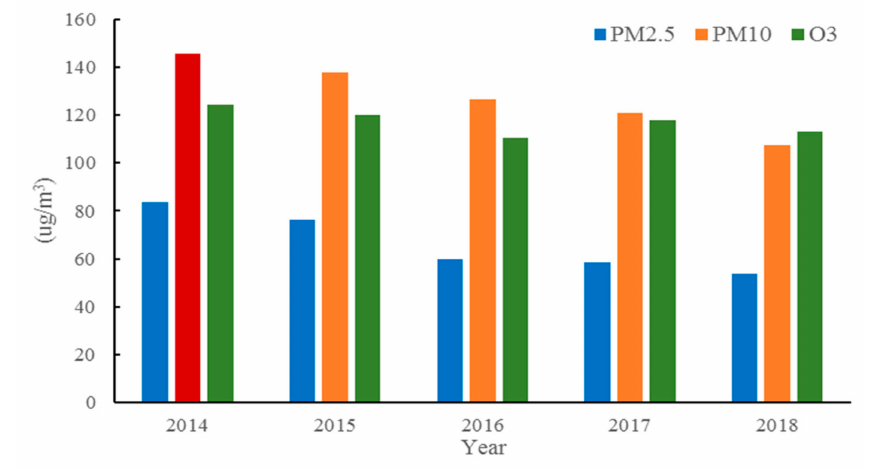
Figure 6. Annual average concentration of the pollutants that a ff ect the AQI in